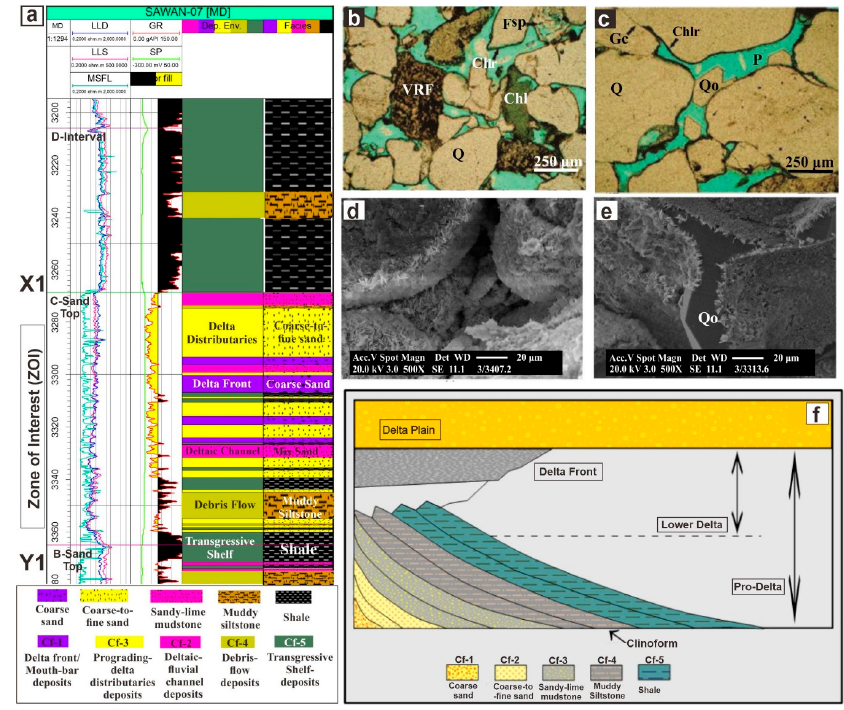
Figure 2. ( a ) Well-log facies classification of the S-08 well representing the various gamma-ray (GR) shape patterns for the identification of five lithofacies along with their depositional environment within the ZOI. ( b , c ) Thin-sections, and ( d , e ) scanning electron microscopy (SEM) images of the Lower Goru sands (LGSs) are illustrating the diagenetic features, where Q = quartz, Qo = idiomorphic quartz outgrowths, Chl = chlorite, Chlr = chlorite-rims, Gc = grain-contact, P = porosity is 16% [48]. ( f ) 2D cross-section showing the reservoir facies model of the Lower Goru Formation (LGF) within the SGF